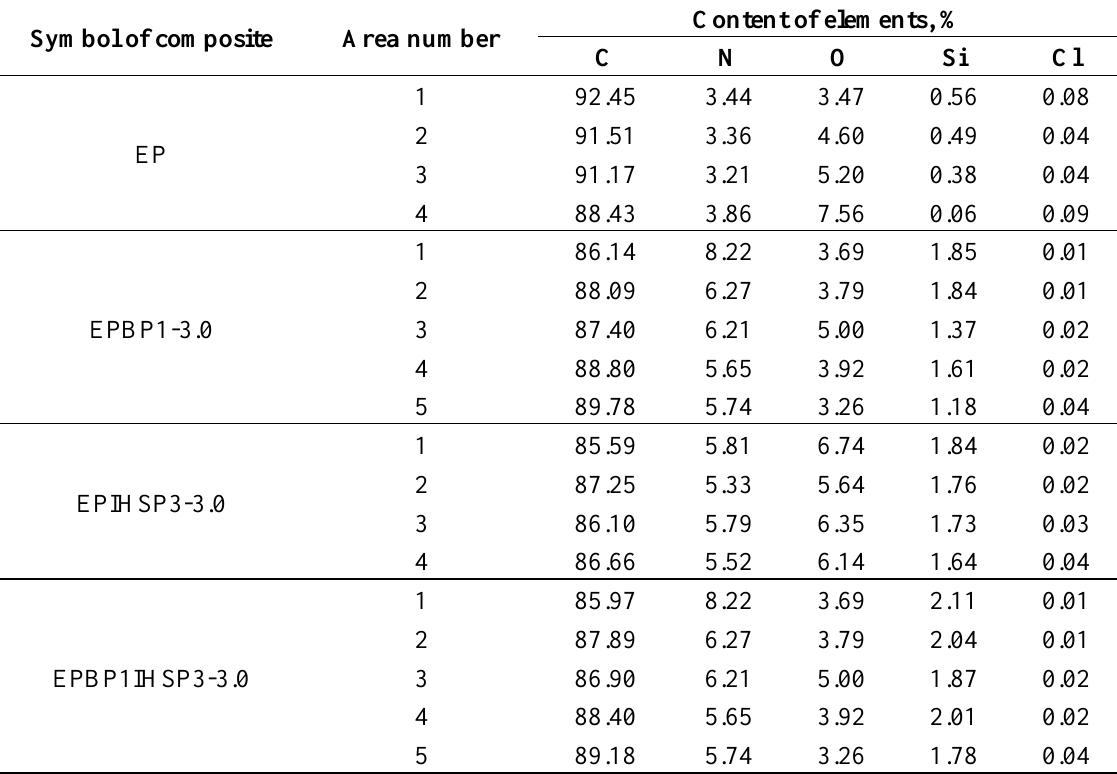
Table 8. Results of EDS analysis of surface composition of burnt samples of EP and